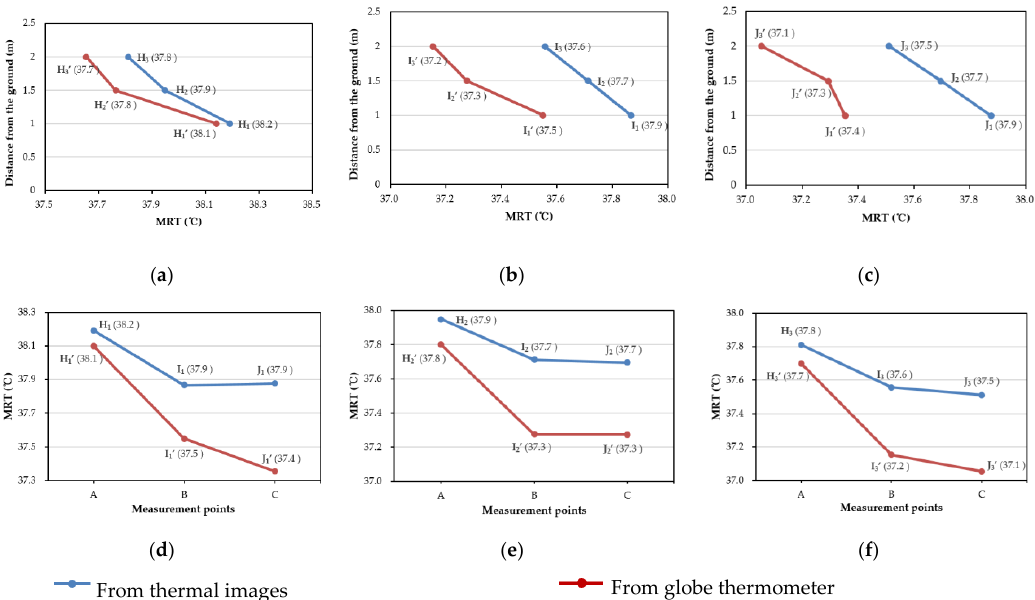
Figure 11. Comparison of MRTs estimated from measured data of the globe thermometer and thermal images at the same measurement time. ( a ) MRT values for measurement points at heights of 1, 1.5 and 2 m at location H; ( b ) MRT values for measurement points at heights of 1, 1.5 and 2 m at location I; ( c ) MRT values for measurement points at heights of 1, 1.5 and 2 m at location J; ( d ) MRT values at 1 m high at three locations H–J; ( e ) MRT values at 1.5 m high at three locations H–J; ( f ) MRT values at 2 m high at three locations